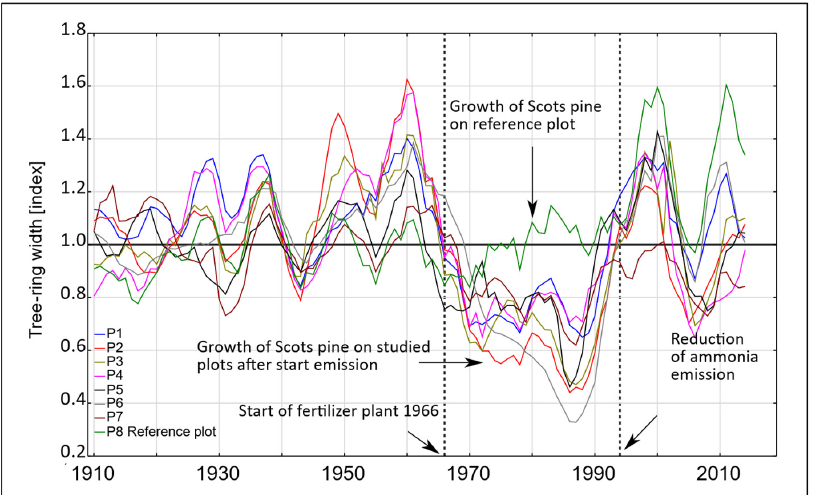
Figure 5. Chronologies of the Scots pines growing in the vicinity of Zakłady Azotowe Puławy. com- missioning of the nitrogen fertiliser plant, which is when the pollutant emissions began. Reductions occurred in a majority of the trees under study (Table 1), although they were differentiated spatially and temporally. Table 1. Characteristics of tree-ring chronologies, and results of calculation of growth changes un- der influence of air pollution from the nitrogen fertilizer factory in Pu ł awy.